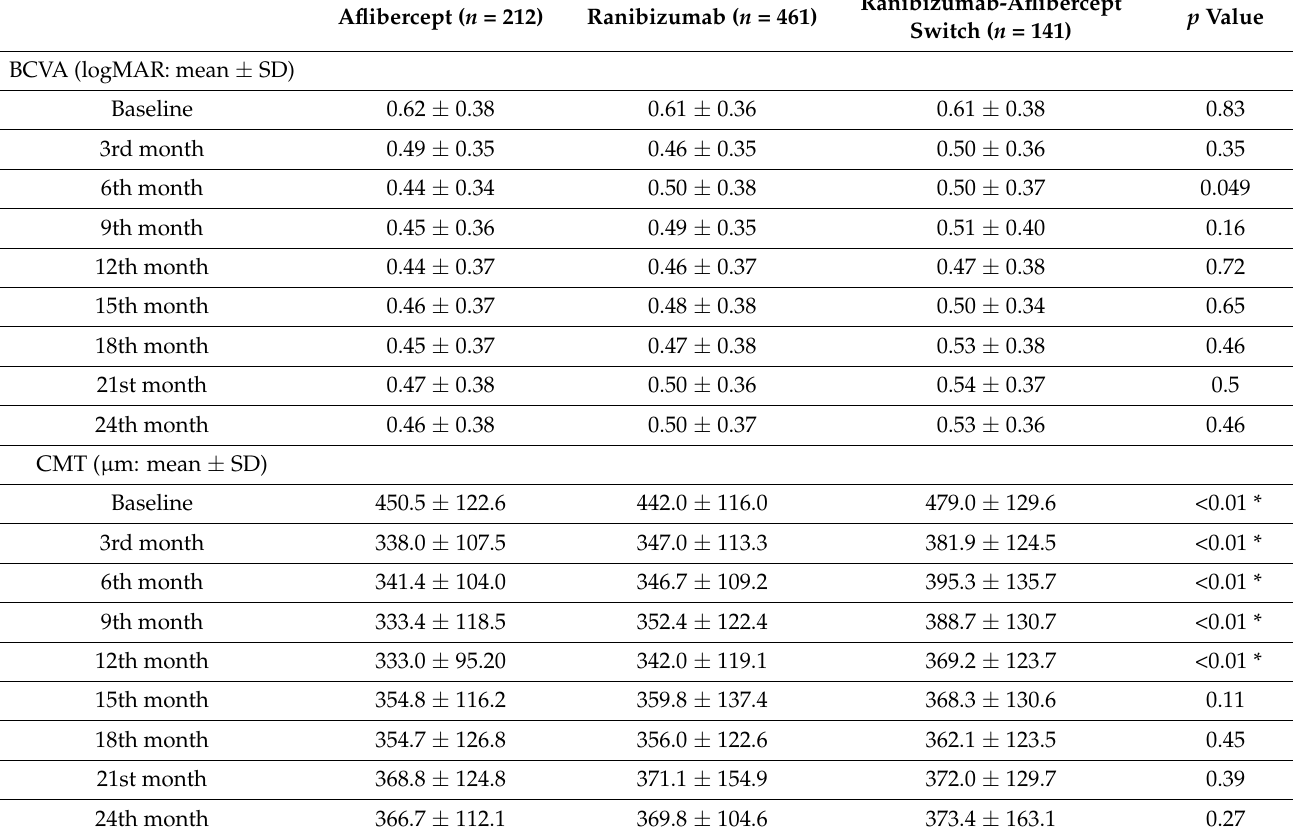
Table 3. Best corrected visual acuity (BCVA) and central macular thickness (CMT) changes through 2-year follow-up among the study groups. Aflibercept ( n = 212) Ranibizumab ( n = 461)